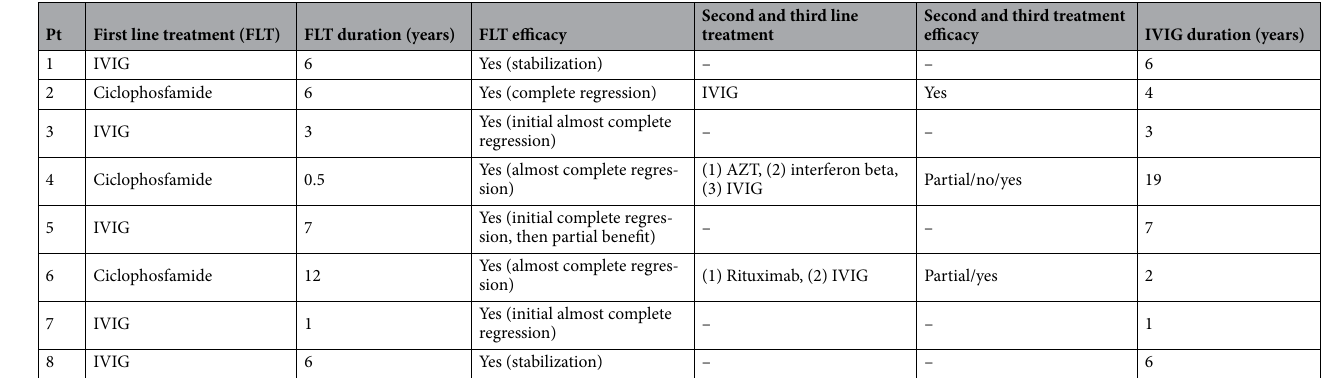
Table 2. Type and length of treatment courses. Pt patient, IVIG intravenous immunoglobulin, AZT azathioprine.